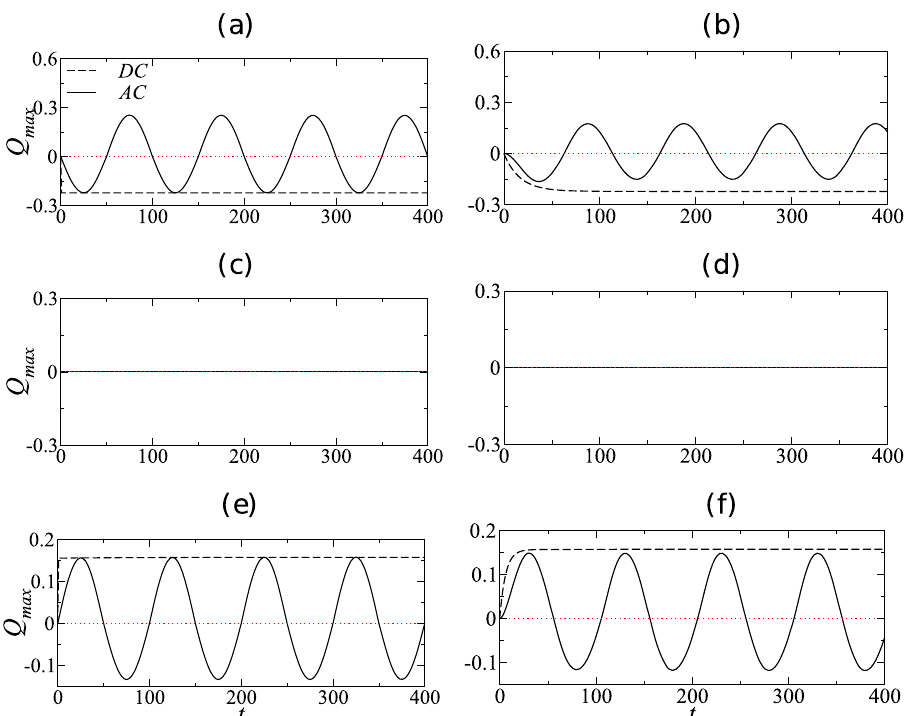
Fig. 3 Interfacial charge buildup in the cases of AC and equivalent DC fi elds. Temporal variation of the maximum interfacial charge, Q max : a , c , e O c = 0.01 and b , d , f O c = 10. Panels ( a , b ), ( c , d ), and ( e , f ) are for ( ε = 10 and σ = 6), ( ε = 10 and σ = 10), and ( ε = 6 and σ = 10), respectively. Here, for all the AC cases, Ω = π compared to the right panels 3(b, d). Also, the sign and magnitude of the steady-state surface charge is governed by the term ( σ − ε ). Panels 3a, b correspond to ε = 10 and σ = 6, where σ < ε and